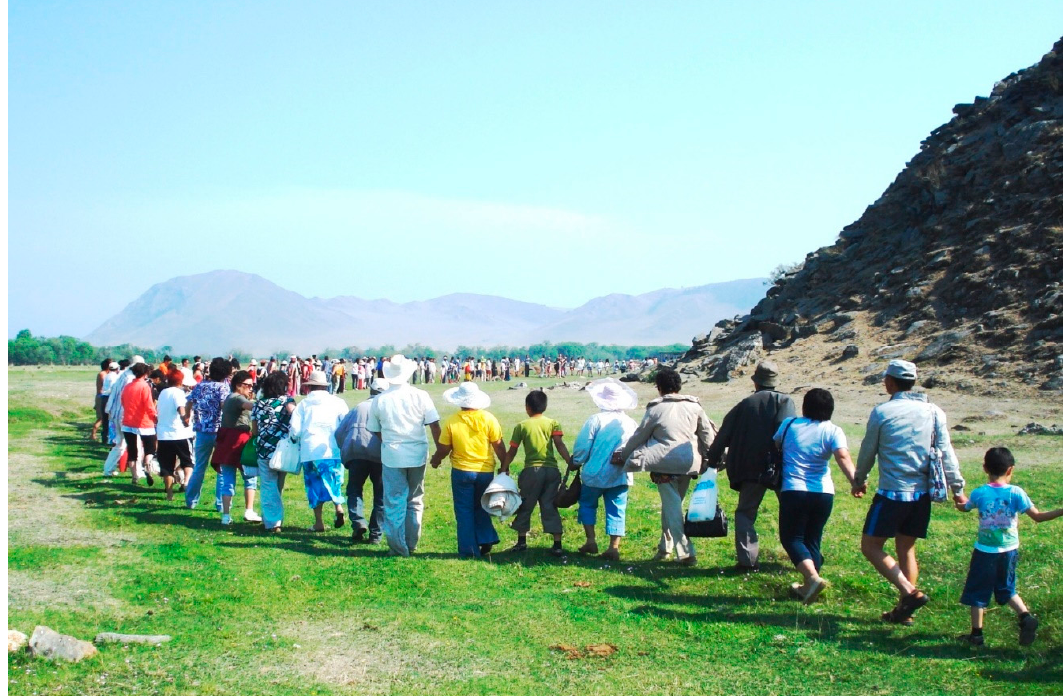
Figure 9. Buryat and other worshippers dancing a giant “yokhor” round dance around the hill “Yord” to allow the coming year to be a good one (2011). Photo: Stefan Krist.